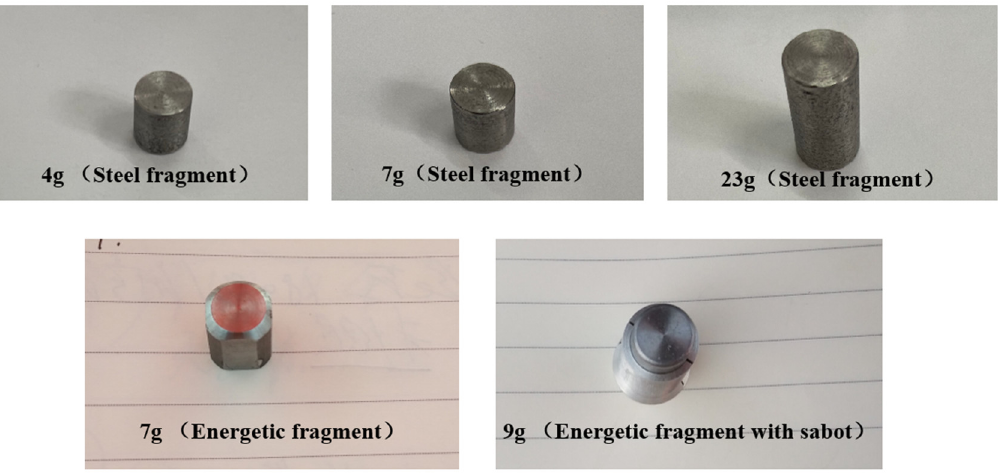
Figure 2. Inert steel fragments and energetic fragments.